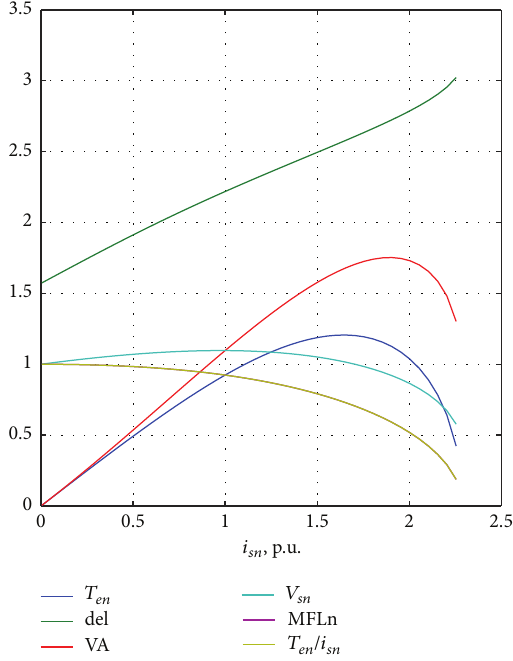
Figure 8: Performance characteristics of PMSM for angle control of air gap flux and current